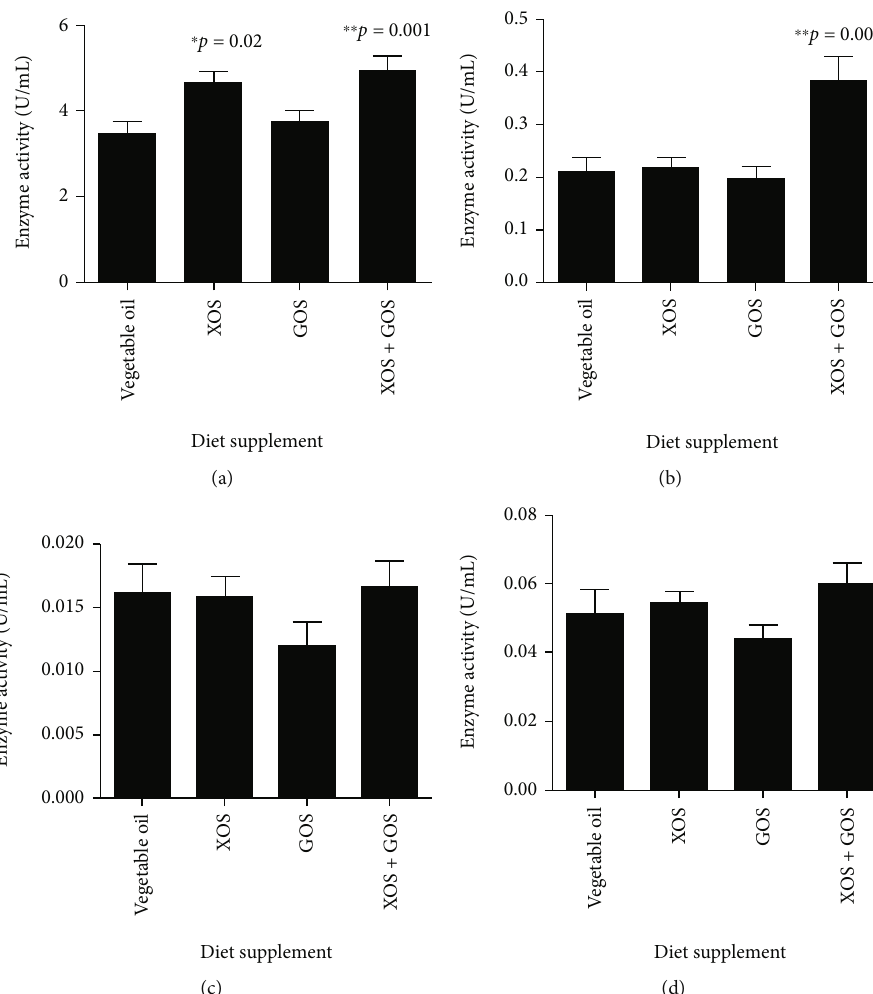
Figure 4: Enzymatic analysis. The activities of metabolism-related enzymes, including glutathione peroxidase (a), pyruvate kinase (b), superoxide dismutase (c), and catalase (d), were tested. ∗ 0 : 01 < p < 0 : 05 ; ∗∗ p < 0 : 01 ; n = 10 − 12